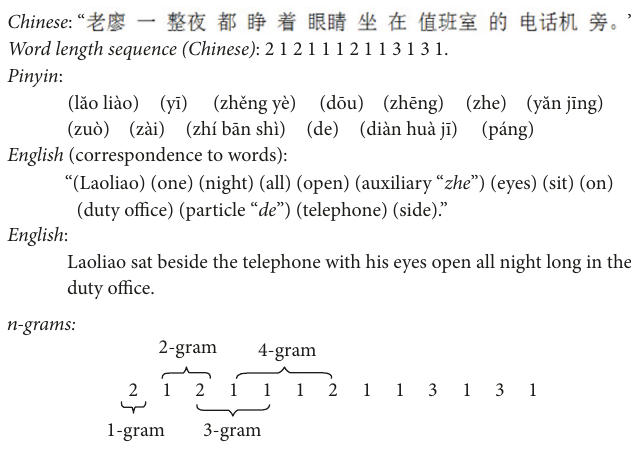
Figure 1: The word length sequence derived from a sentence. Table 2: The frequencies and probability distribution of 2-gram word length sequences of the sentence in Figure